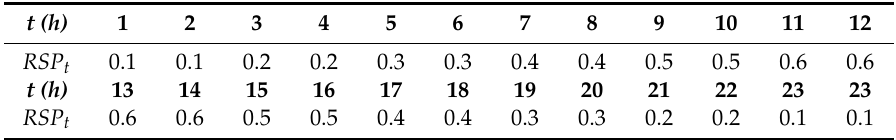
Table 3. RSP t values for the numerical example